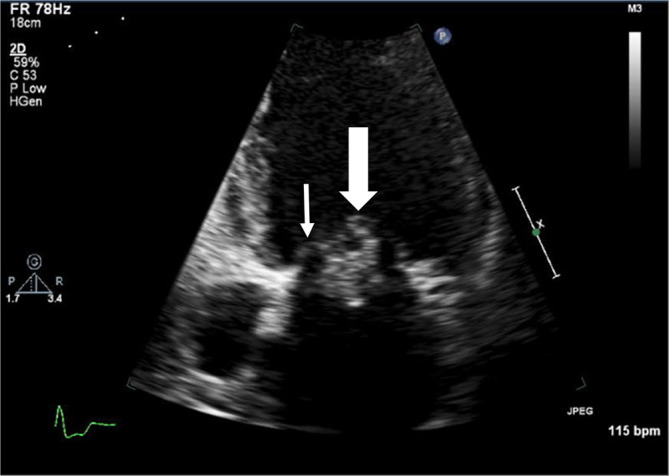
Echocardiogram performed on the first day in hospital. A movable mass (large white arrow, 23.7mm×14.9mm) can be seen on the anterior mitral leaflet (small white arrow), and this caused the valve annulus to adhere to the valve leaflet.